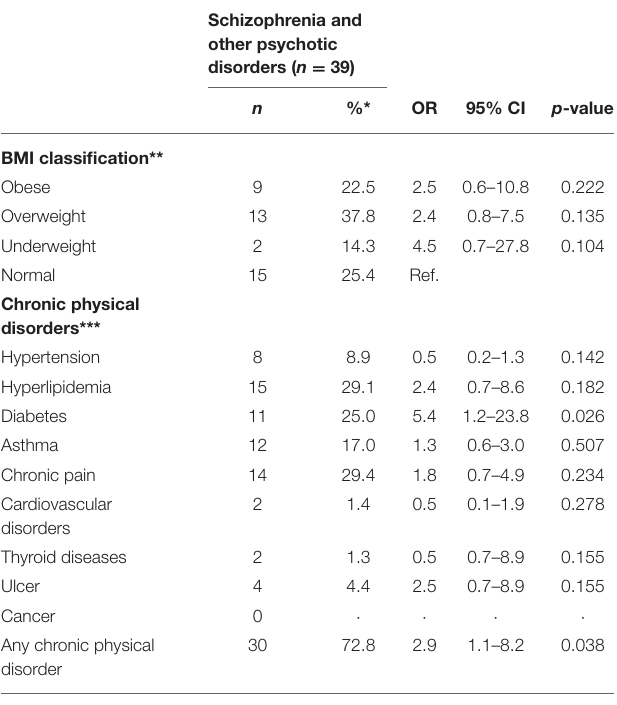
TABLE 4 | Association between lifetime schizophrenia and other psychotic disorders, body mass index categories and chronic physical